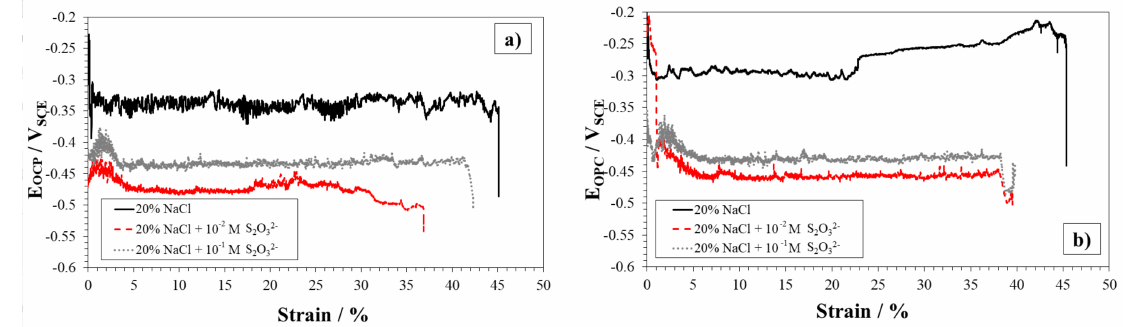
Figure 6. E OCP -strain trends of DSS 2304 ( a ) and LDSS 2404 ( b ) during SSRT in 20% NaCl solution at 80 ◦ C, in the absence and presence of 10 − 2 and 10 − 1 M S 2 O 32 − .